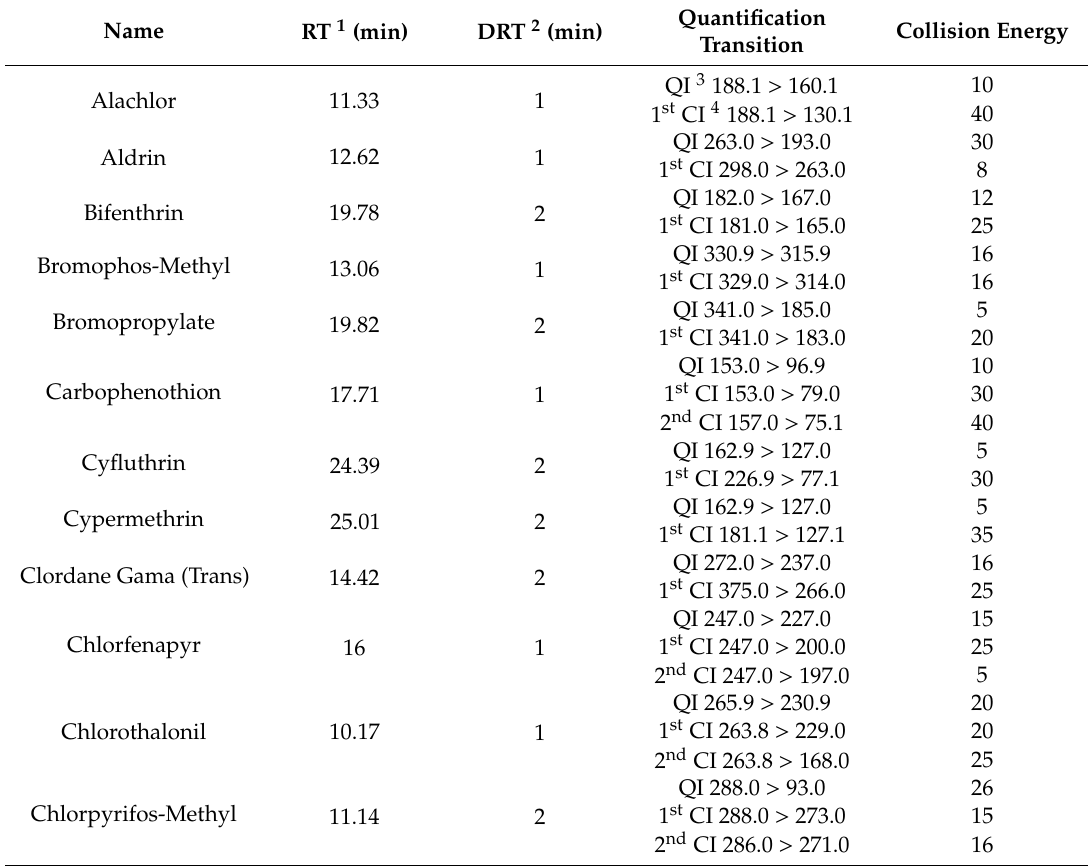
Table 2. Chromatographic parameters and MS / MS detection for compounds analyzed by GC-MS / MS (gas chromatography tandem mass spectrometric